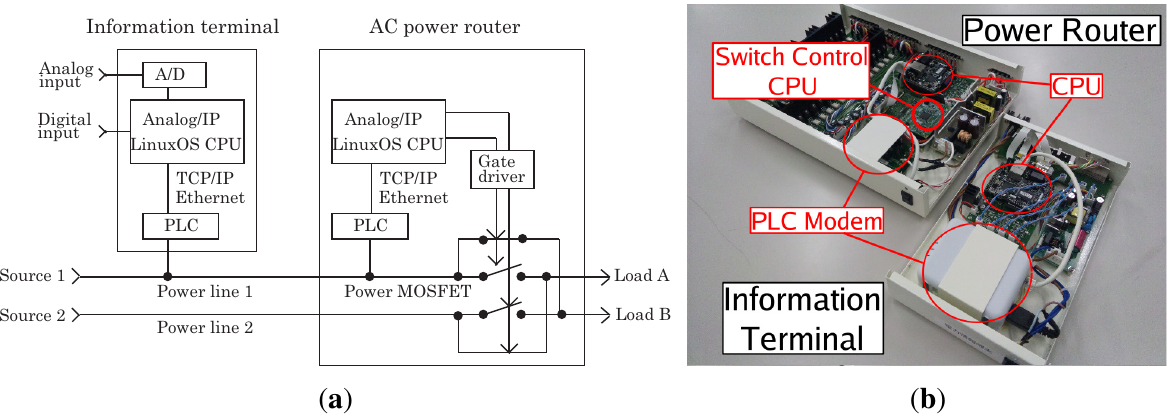
Figure 2. Schematic diagram of the connection setup and a photograph of an AC power routing system: ( a ) setup of AC power router and information terminal; and ( b ) a photograph of prototype AC power router and information